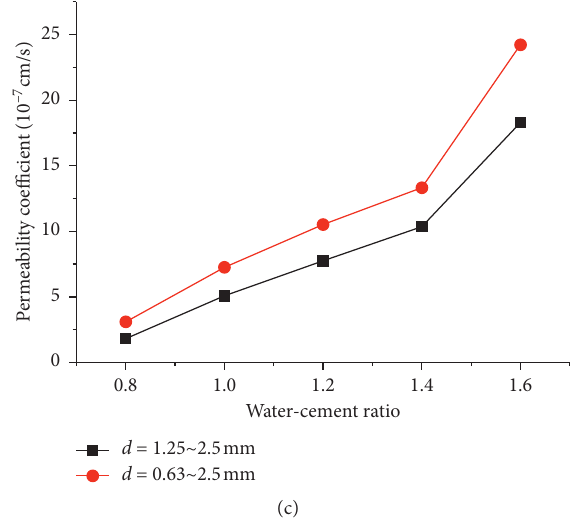
Figure 7: Influence of water-cement ratio on grouting effect in sand. (a) 3d compressive strength. (b) 3d deformation modulus. (c) 1d permeability coefficient.